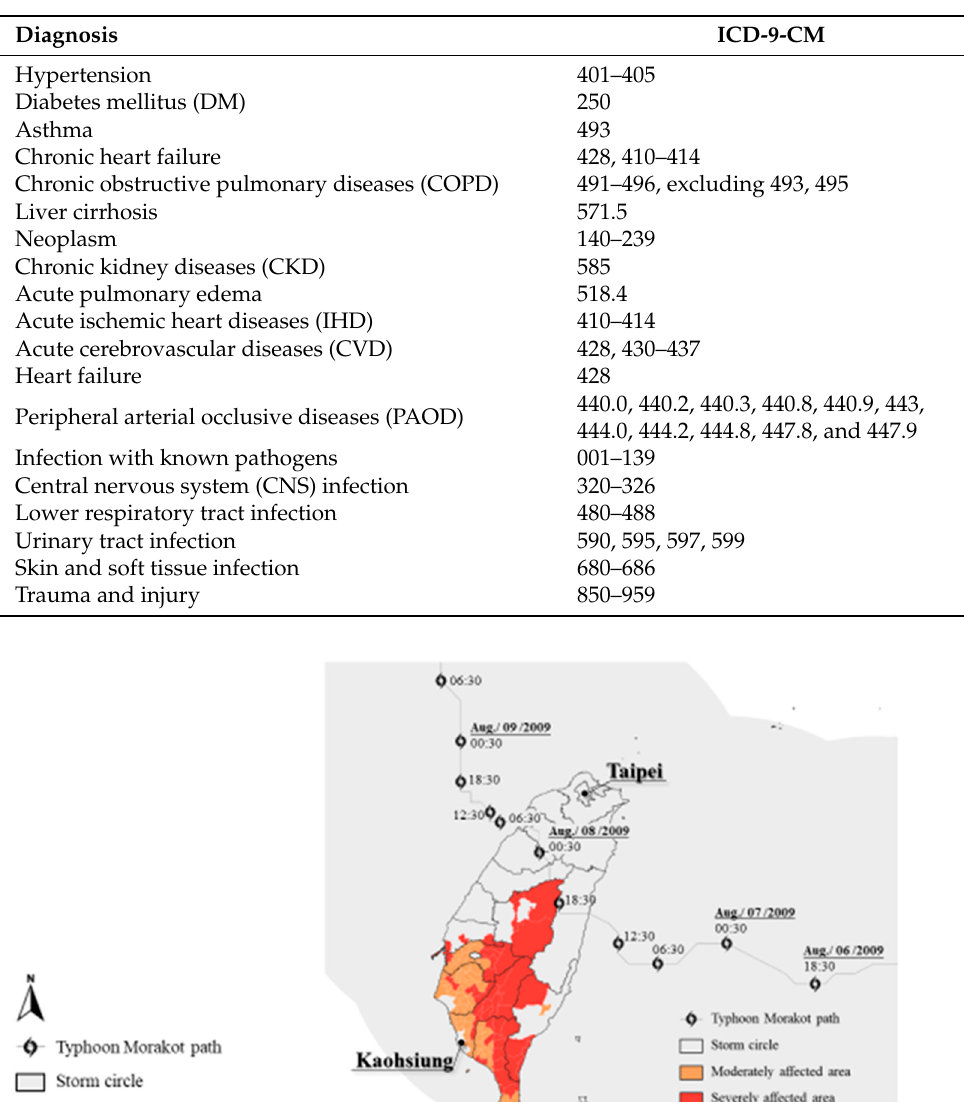
Table A1. Selected ICD-CM9 Used for Analysis.